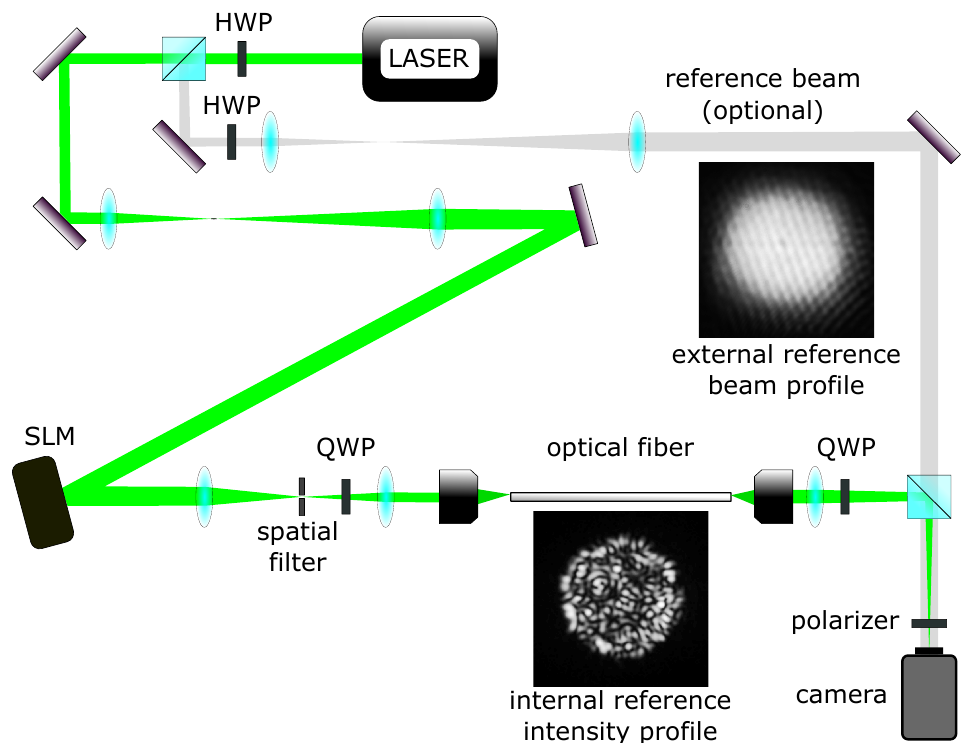
Figure 1. Experimental apparatus is an in-line holographic setup as both reference and signal waves are guided via optical fibre. Laser—infrared, λ = 1070 nm. SLM—pure phase liquid crystal spatial light modulator. HWP, QWP—half-waveplate and quarter-waveplate, respectively. See text for detailed